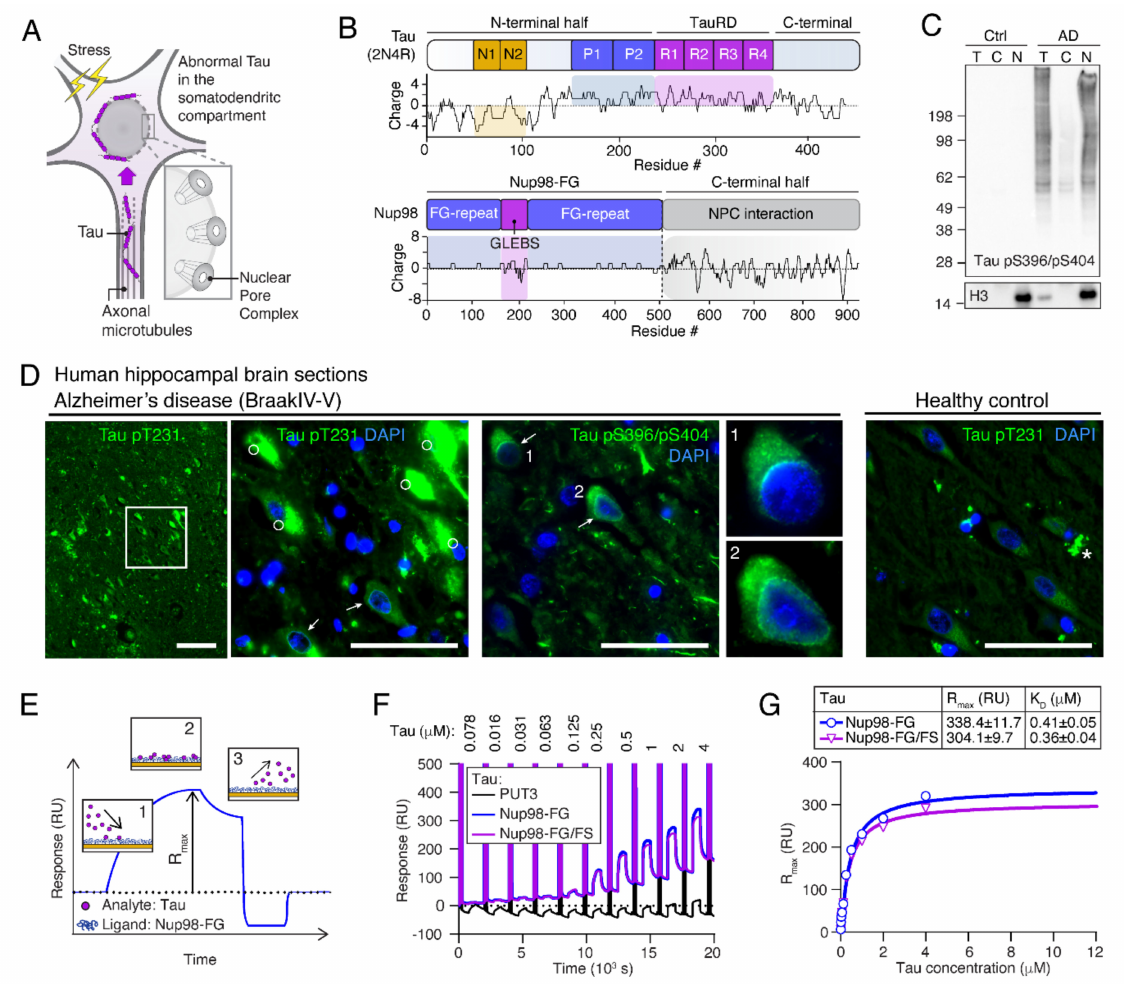
Figure 1. Tau accumulates at neuronal NEs in AD brains and binds to Nup98-FG. ( A ) Scheme of cellular Tau localization. Under normal conditions, the microtubule-associated Tau protein is restricted to the neuronal axon. Upon stress and under disease conditions, Tau mislocalizes to the neuronal cell body where it comes into close proximity with the nucleus; interactions with components of the NPC are enabled. ( B ) Domain structure and charge distribution along the se- quence of human full-length wild-type Tau (2N4R, 441 aa) and Nup98 (937 aa) analyzed using EMBOSS (http://www.bioinformatics.nl/cgi-bin/emboss/charge; accessed on 10 January 2022) with a sliding window of 8 aa. The N-terminal inserts (N1, N2; yellow) are predominantly nega- tively charged, the pseudo-repeat domain (R1-R4; purple) and adjacent Proline-rich domains (P1, P2; blue) are positively charged. For Nup98, the C-terminal part (grey) is anchored in the NPC scaffold, whereas the N-terminal part (Nup98-FG; blue/purple) protrudes unstructured into the pore of NPC and contains two non-charged FG-rich domains separated by the negatively charged GLEBS domain (Gle2-binding sequence). ( C ) Western Blot analysis of human postmortem brain tissue shows phosphorylated Tau (pS396/pS404) in isolated nuclei (N) of AD but not control cases (T = Total lysate; C = Cytosol; N = Nuclei). Histone H3 is loaded to control for nuclei enrichment. ( D ) Immunolabeling of phosphorylated Tau (pT231 and pS396/pS404) in AD Braak 4/5 hippocampal brain sections shows the side-by-side existence of neurofibrillary tangles (NFTs, white circles) filled with aggregated phospho-Tau and neurons with phospho-Tau accumulating in a layer at the nuclear envelope (white arrows). Notably, compared to neuronal nuclei, cell nuclei of glia cells appear smaller and brighter in the DAPI channel. The asterisk in the healthy control brain section